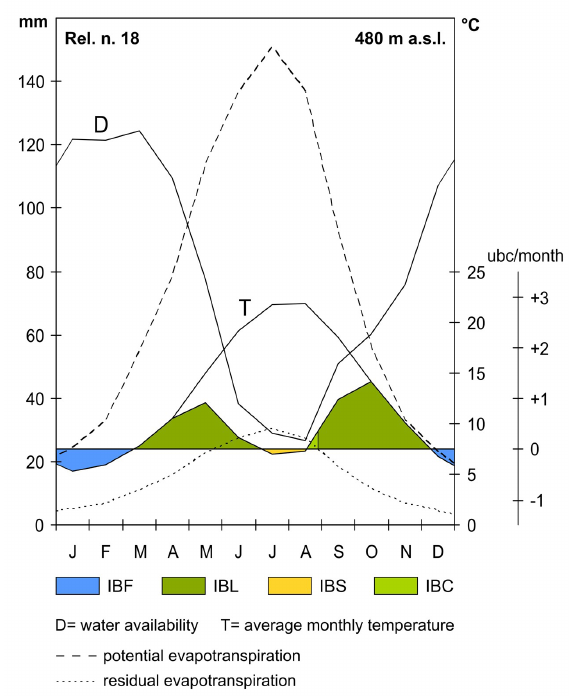
Figure 3. Bioclimatic diagram according to Montero de Burgos and González Rebollar. (IBF = Cold bioclimatic intensity; IBL = Free Bioclimatic Intensity; IBS = Dry Bioclimatic Intensity; IBC = Conditional Bioclimatic Intensity).